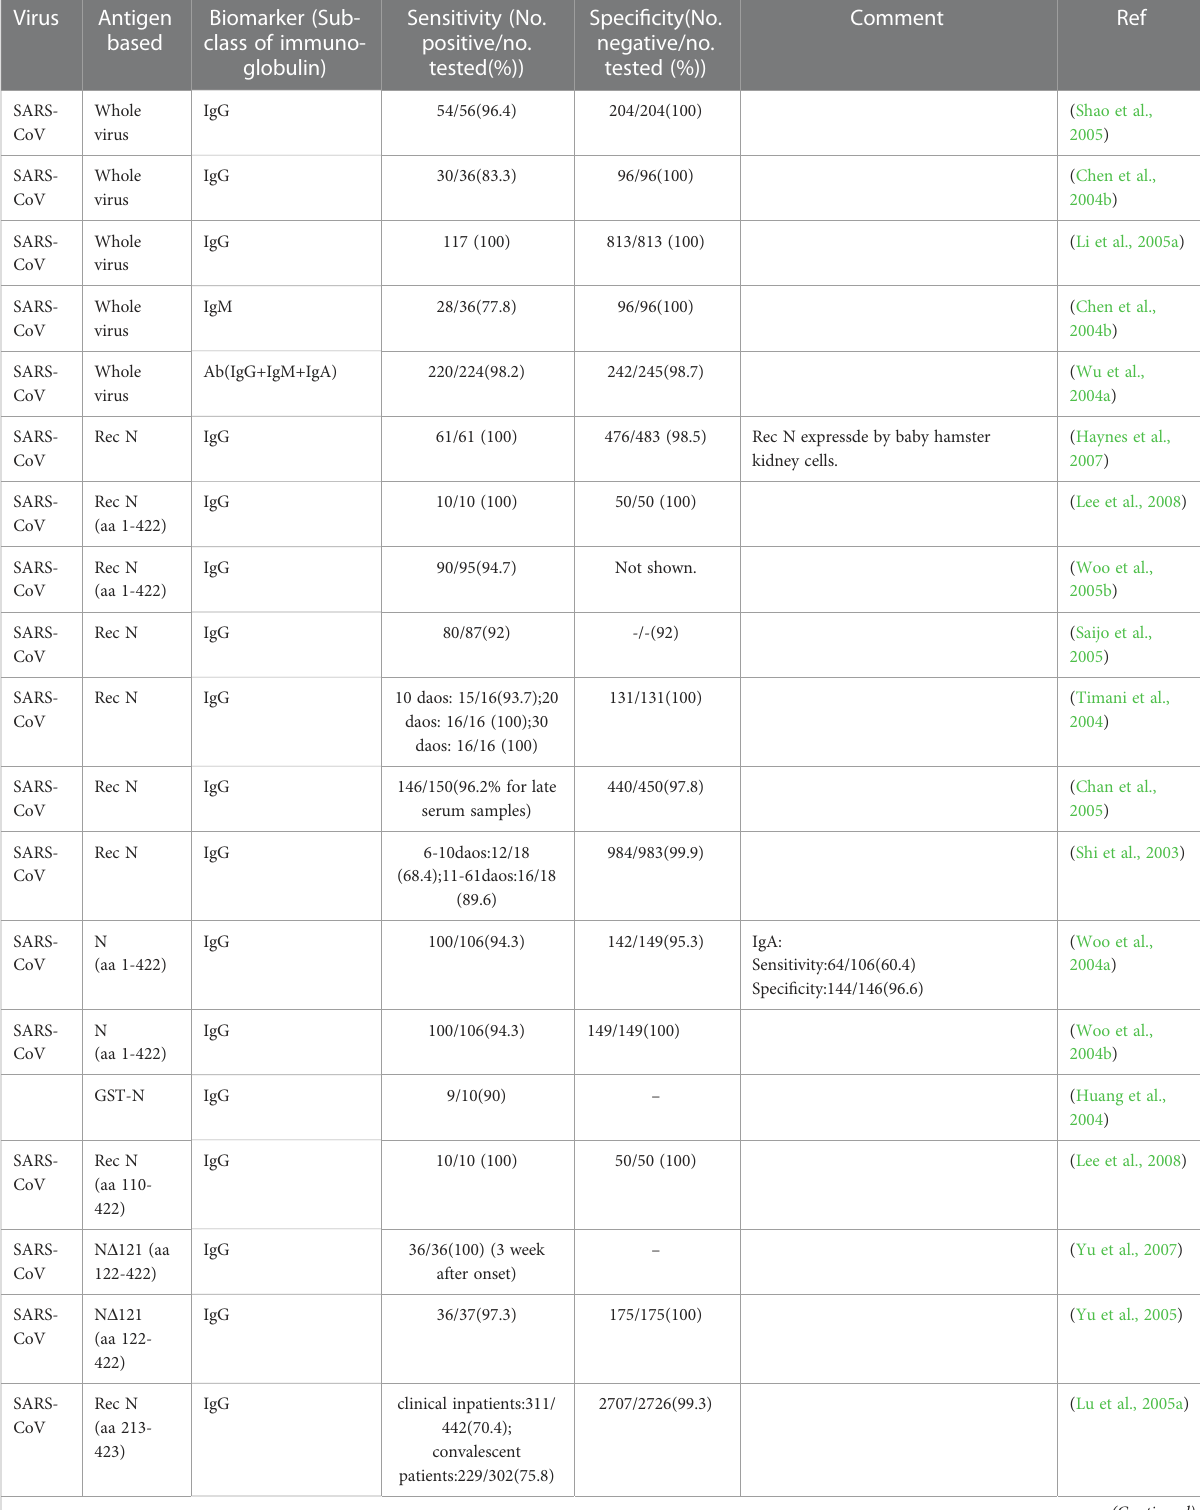
TABLE 3 ELISA for antibody detection validated by clinical